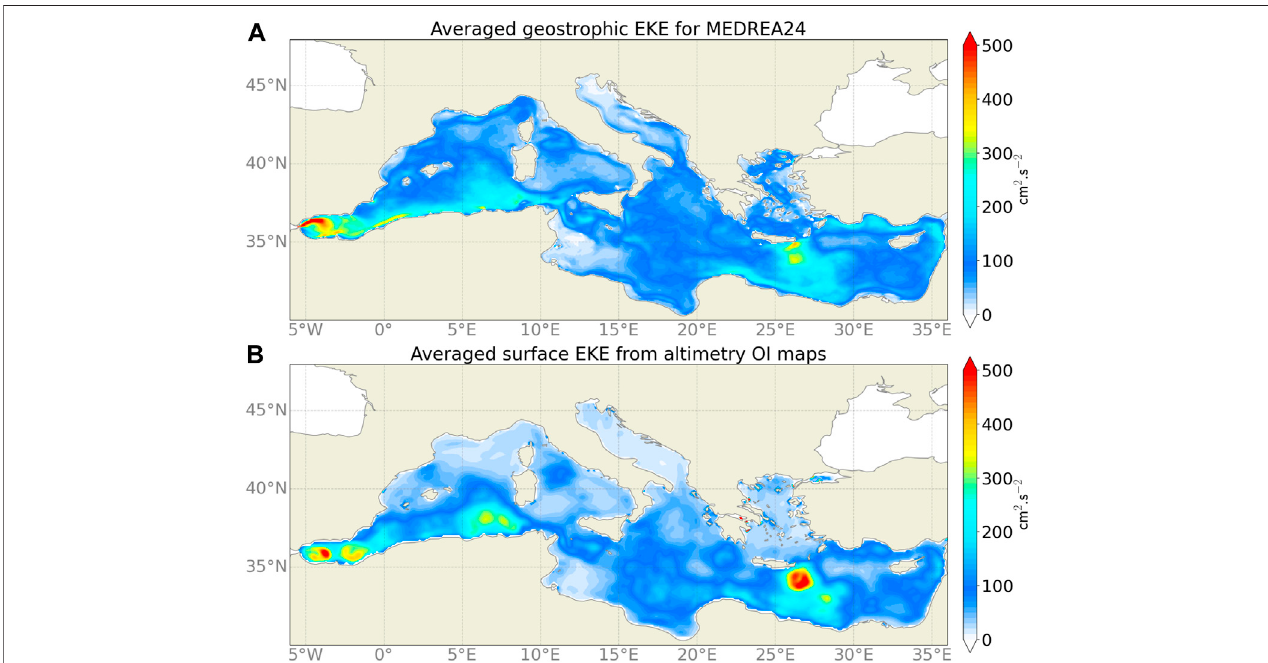
FIGURE 13 | Average geostrophic EKE (in cm 2 . s − 2 ) computed from MEDREA24 SSH (A) and altimetry interpolated maps (B) for the period 1987 – 2019.